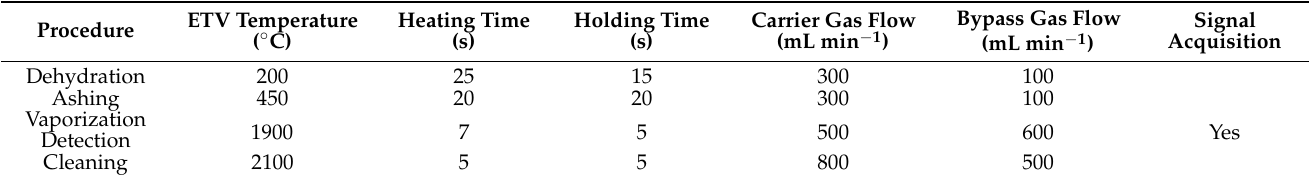
Table 3. Instrumental program of direct sampling ETV device.